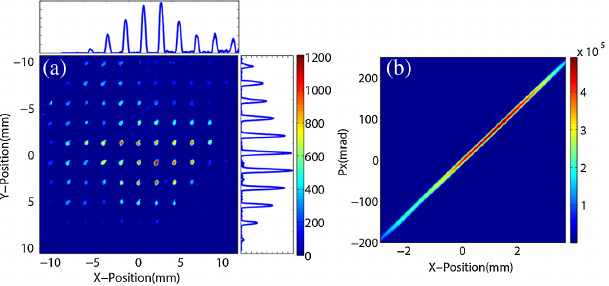
FIG. 2. Experimental results using the pepper-pot method. (a) Raw data from the RCF detector; detected proton energy is ( 5 . 0 (cid:1) 0 . 1 ) MeV. (b) Interpolated phase space diagram. Color scale is the proton count.